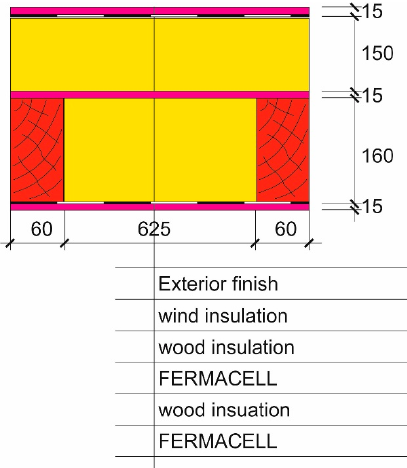
Figure 6. Cross-section through the external walls of the analysed buildings.